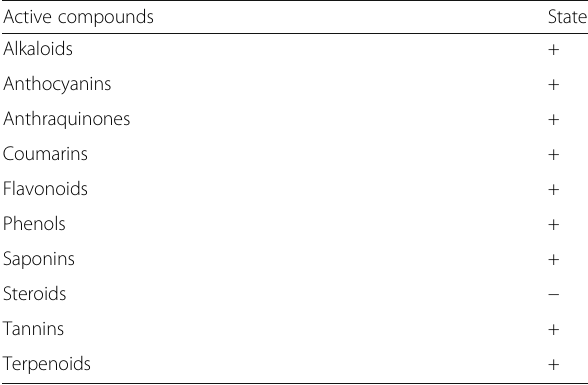
Table 1 Chemical groups of compounds found in the aqueous extract from the leaves of A. cordifolia Active compounds